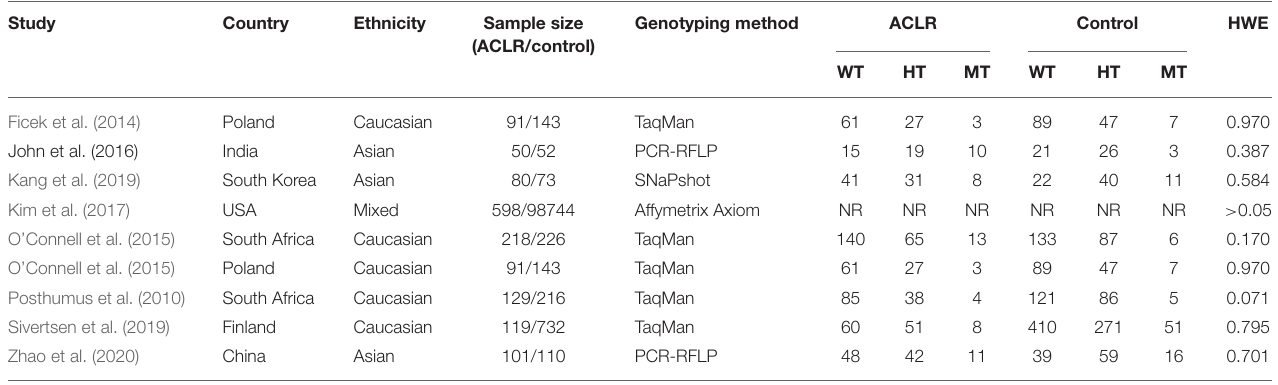
TABLE 1 | Main characteristics of included studies.